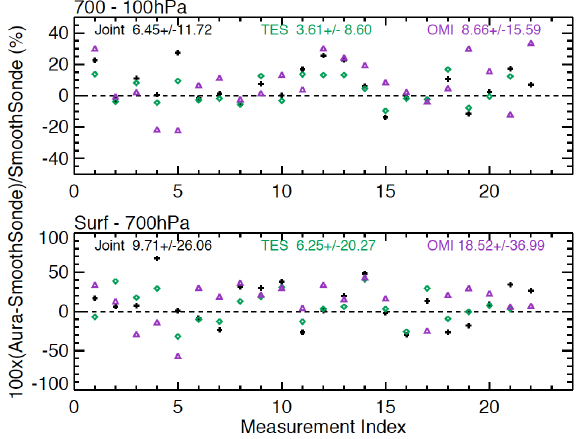
Fig. 4. Ozone volume mixing ratios measured by the instruments on Aura satellite and ozonesonde over Wallops Island, Virginia, USA, on 2 October 2007. It is the same scenario as the one shown in Fig. 2. (A) Joint TES and OMI vs. Ozonesonde; (B) TES only vs. Ozonesonde; (C) OMI only vs. Ozonesonde; (D) percentage differences between joint retrieval and co-located sonde measurements; (E) percentage differences between TES retrieval and co-located sonde measurements; and (F) percentage differences between OMI retrieval and co-located sonde measurements. In (A) , (B) and (C) , retrieved profiles are in green; ozonesonde measurements are in black; ozonesonde profiles smoothed by averaging kernels of TES or OMI are in blue; and a priori are in magenta.